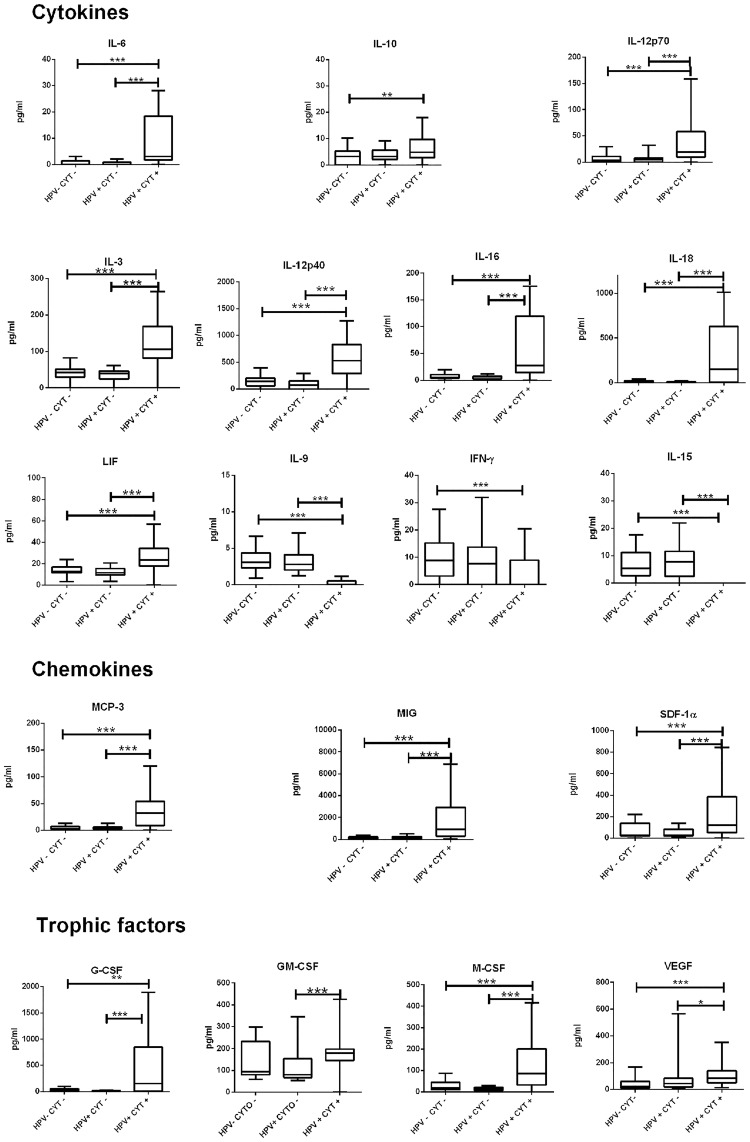
Expression of significant immune mediators in cervical fluid of HR-HPV positive women.The median values of the specific protein found down and up regulated in the local microenvironment of HR-HPV positive women without and with cervical lesions compared to the control group. The box plots show the expression levels (ρg/mL) of the cytokines found to be statistically significant between the study groups. Data expressed as median values are reported in Table 4. The significant results are marked with asterisks: *p<0.05, **p<0.01, ***p<0.001.